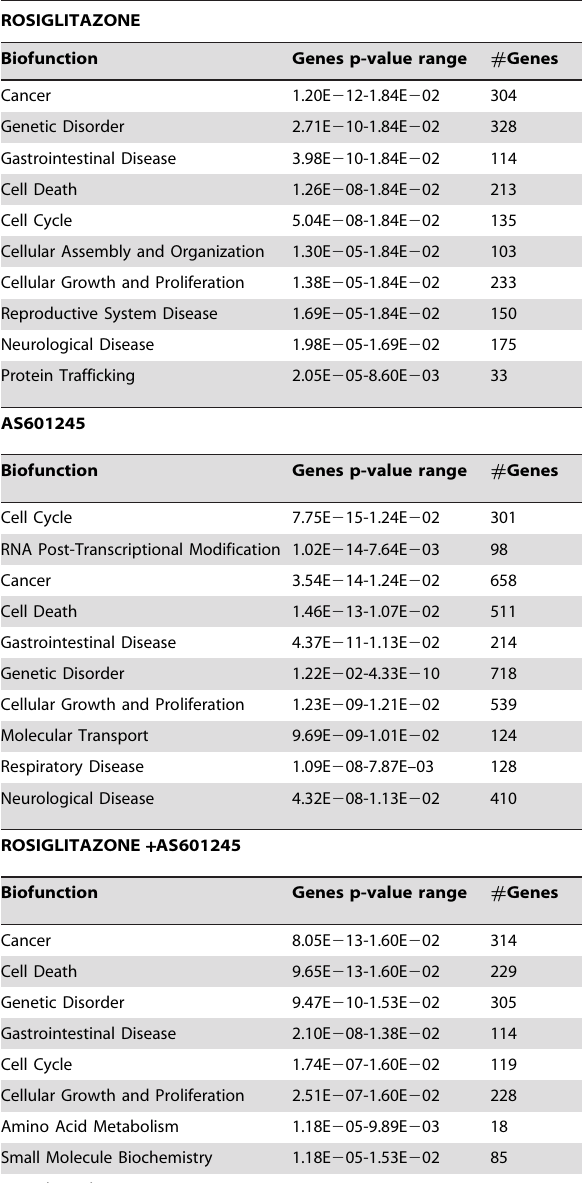
Table 1. Biological